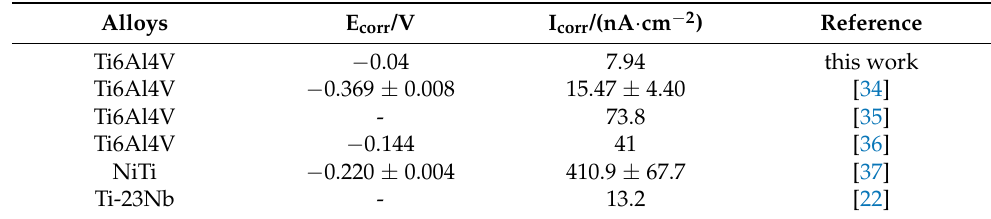
Table 3. Corrosion parameters observed from potentiodynamic polarization for LPBF titanium alloys in the SBF at 37 ◦